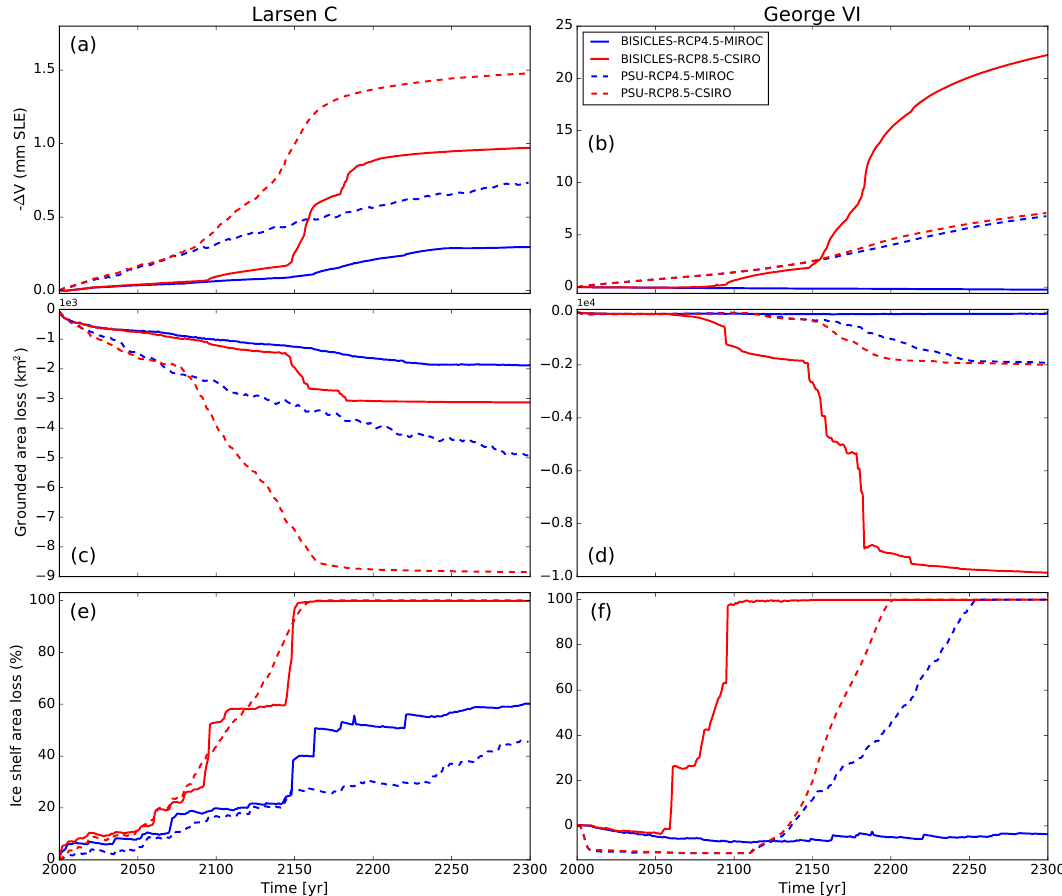
Figure 7. SLR projections from Experiment 2 (dynamic calving front) for Larsen C (a) and George VI ice shelves (b) with corresponding area loss of grounded ice (c, d) and ice-shelf area loss (e, f) . MIROC and CSIRO denote the selected global climate model